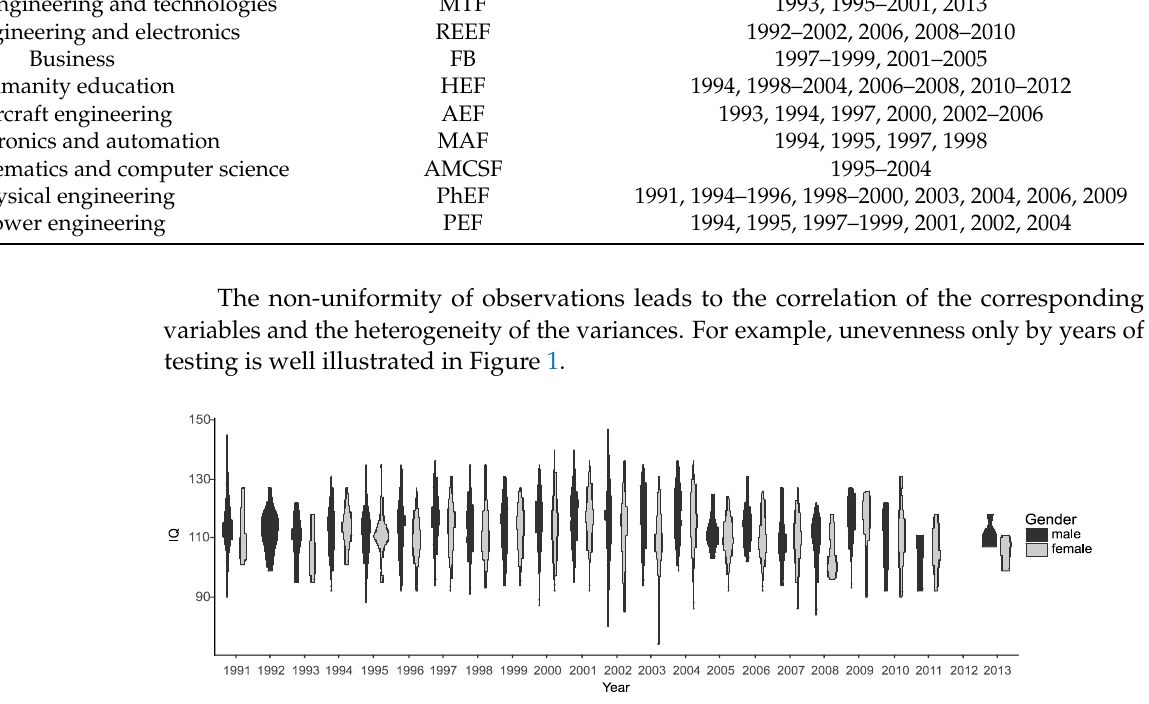
Figure 1. Violin plot of the numerical IQ variable distributed by the years.